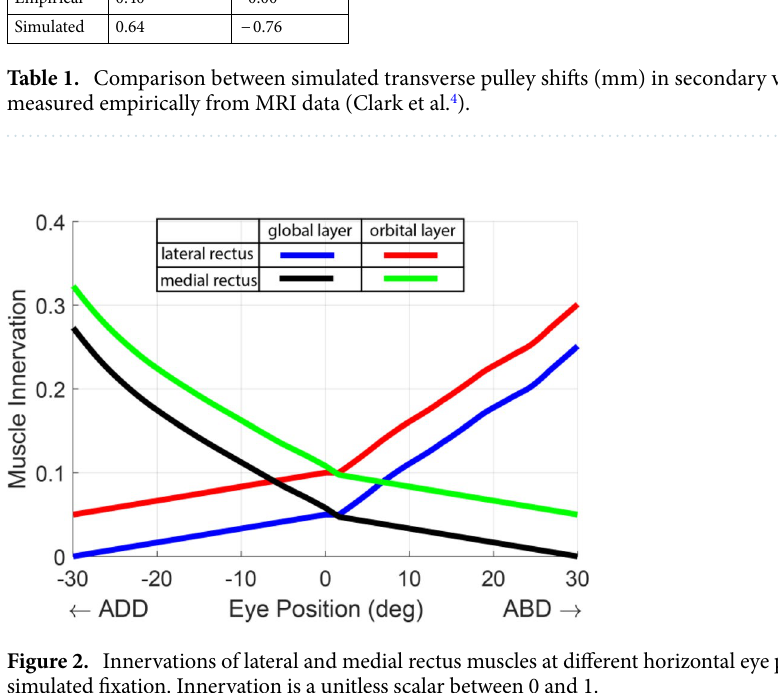
Figure 2 shows computed LR and MR innervations as functions of horizontal eye position between 30 o adduction and 30° abduction. By constraint consistent with human electromyographic data, the OL has greater innervation than GL throughout the field of action of each EOM. Innervations of OL and GL progressively increased as the eye rotates in the ON direction of the corresponding EOM. The relationships between innerva- tion and eye position was roughly parabolic rather than linear. Similar roughly parabolic curves for OL and GL innervations as functions of eye positions based on electro- myography were reported by Collins 17 , who attributed the parabolic relationship to staggered fiber recruitment. This consistency between the EOM innervation profiles computed from the neural controller shown in Fig. 2 and the electromyographic measurement of GL and OL fiber innervations from human medial rectus muscle during fixation and slow eye movement 17 demonstrates our model’s realism, which otherwise might have required non-physiologic innervation. Both OL and GL remain active during fixation far outside the field of action of the corresponding EOM, which was also observed experimentally 17 . Simulated LR and MR tensions as functions of horizontal eye position are shown in Fig. 3. During progres- sive rotation from 30° add- to 30° abduction, simulated MR insertional force corresponded with empirical measurements on unrestrained eye movement 26 , both in pattern and tension magnitude. MR force was about 25 g at 30° adduction, decreased as the eye moved temporally. After reaching its minimum, MR tension at its insertion increased to reach 10 g at 30° abduction. A similar relationship was observed for force at the LR inser- tion. The force increase at an EOM’s insertion in its extreme inhibited field of action is probably be caused by the antagonist EOM’s passive elastic force and elastic pulley suspension forces. Both MR OL and GL tensions increased in MR’s field of action as the OL applied significantly greater tension than GL, demonstrating different mechanical actions of OL and GL in fixation. Pulley suspension forces were read out from the simulator. Only the four superior suspensions are shown in Fig. 3. The four inferior suspension forces were identical to their corresponding upper suspensions during horizontal gazes. Pulley suspension forces ranged between 3 and 13 g, all varying with eye position. The anterior superior suspension applied the greatest force and thus contributed the most to stabilizing the pulley tubes transversely. Simulation of horizontal and vertical eye movement was provided in the supplementary video. Horizontal saccades were simulated. Figure 4 simulates a 30° saccade from central gaze to abduction. Simu- lated innervations and tensions of the LR, which is the agonist for this saccade, showed the expected pulse and step pattern. Innervation of the LR OL was higher than that of the LR GL during the main course of this saccade, which is consistent with the recordings of electromyographic activities in the GL and OL of an agonist human EOM 17 , and demonstrates differential laminar functions. The neural controller supplied zero innervation to the